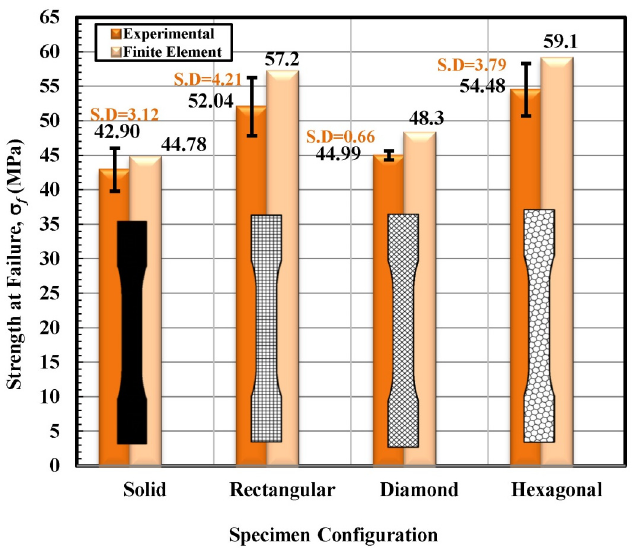
Figure 19. Strength at failure versus specimen configuration for both experimental and finite element analysis.